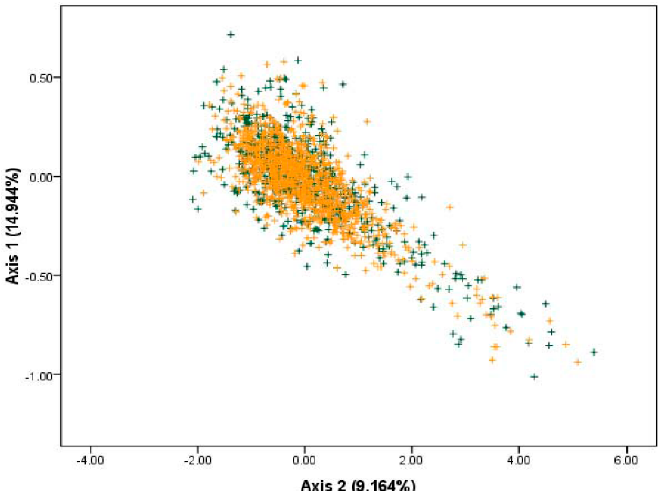
Figure 1. The plot of the two most dominant axes (axis 1 and axis 2) calculated from PCA according to all open reading frames (ORFs) of S. agalactiae genes. Genes located on the leading strand were denoted as green plus signs, whereas orange plus signs indicated lagging strand genes. Axis 1 represented the first major trend and axis 2 represented the second major trend.